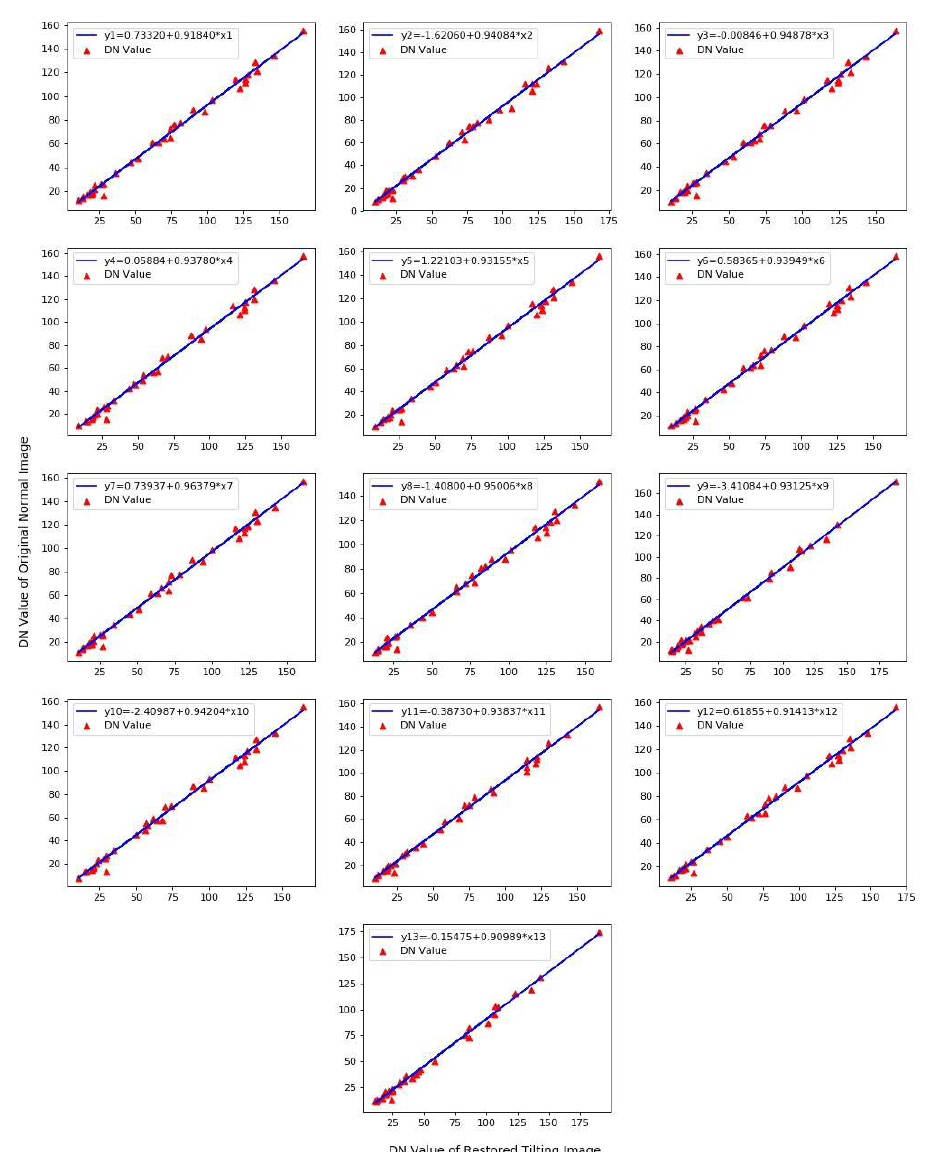
Figure 12. Calibration equation fitting of each restored tilting image band.